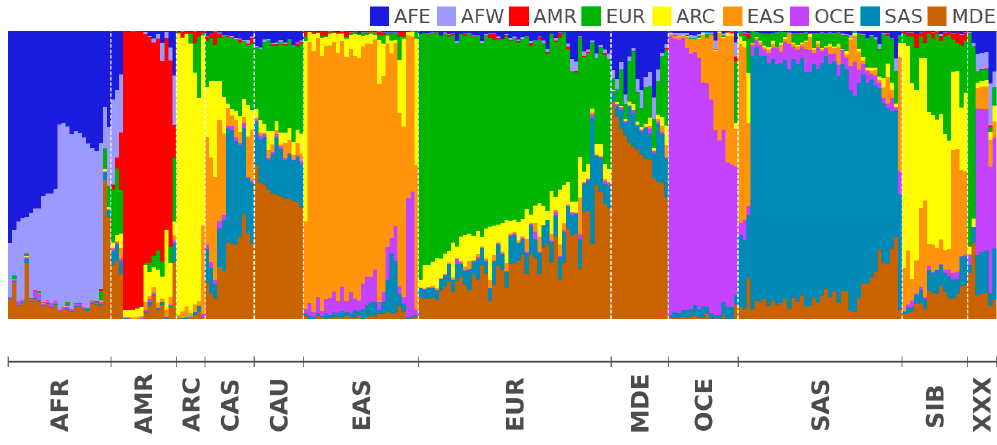
Figure 2. The graphical stacked-bar representation for the Supplementary Table S4. Each bar is a population. The color and the height correspond to the percentage of IBD shared with the corresponding geographical region. The colors denoting geographical regions are given at the top of the graph. The populations are grouped into 12 geographical regions which IDs are given at the bottom of the graph. The populations are ordered within each geographical region by the percentage of shared IBD fragments.